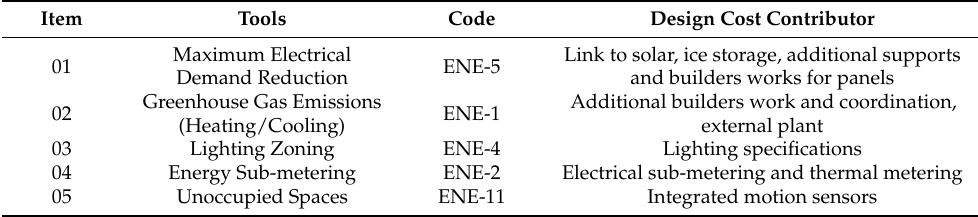
Table 10. Credit summary for energy.